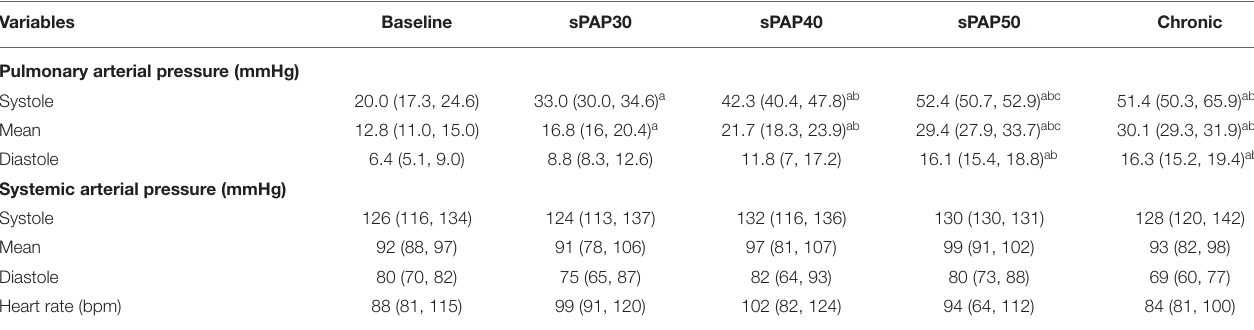
TABLE 1 | Changes in hemodynamic parameters during the process of creating canine models of chronic embolic pulmonary hypertension.